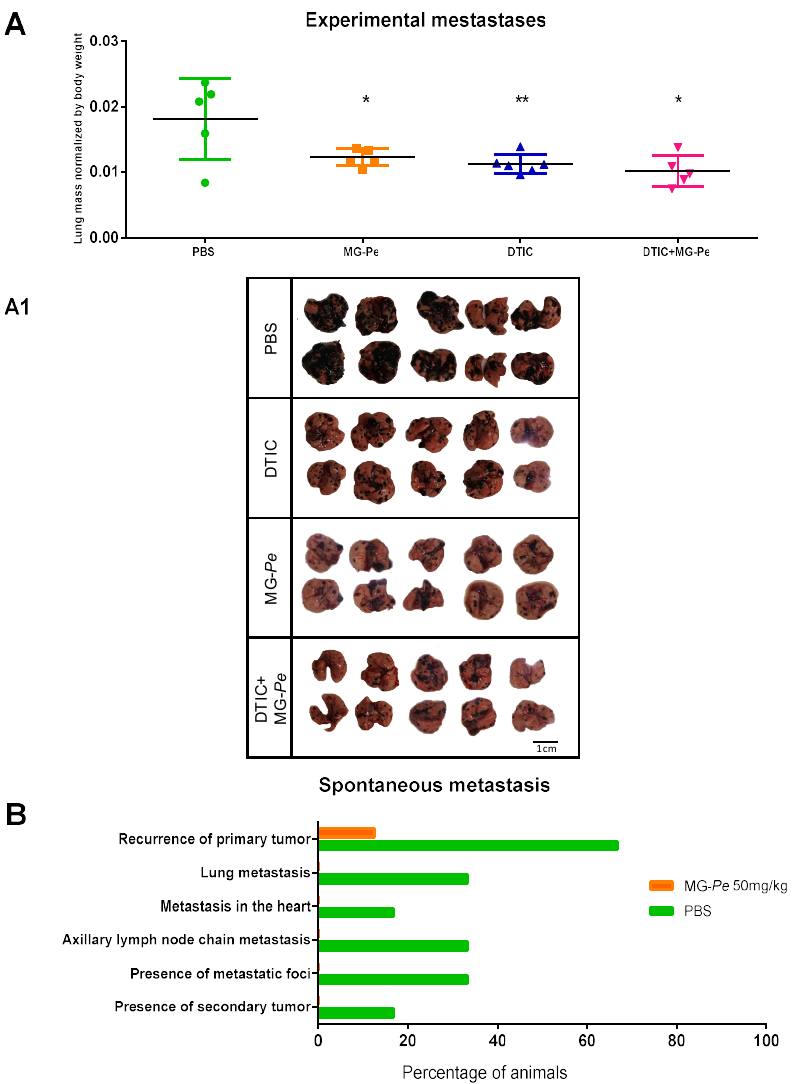
Figure 2 . Analysis of experimental and spontaneous metastases of B16-F10 cells in C57BL/6 mice. ( A ) Experimental metastasis model: cells were intravenously inoculated via lateral caudal vein and treated with: PBS ( n = 5), DTIC (40 mg/kg) ( n = 6), MG-Pe (50 mg/kg) ( n = 6), or DTIC+MG-Pe combination (40 + 50 mg/kg) ( n = 5). The data (mean/SD) were submitted to t -test. * p ≤ 0.05 and ** p ≤ 0.01. ( A1 ) Lung images: dorsal (up) and ventral (down). ( B ) Spontaneous metastasis model: cells were subcutaneously inoculated; animals were treated for 10 days with PBS ( n = 6) or MG-Pe (50 mg/kg) ( n = 8); then tumor removal by surgery (21st day); waited 1 month (without treatment), and finally tumor recurrence was assessed. We evaluated the recurrence of primary tumors in all experimental groups. In the PBS group, 67% of mice (4 of 6 mice) showed tumor development at the surgical removal site (around the 14th day after surgery). By contrast, in the MG- Pe treated group, only 13% of the mice (1 of 8) presented recurrence, on the 16 th day post-surgery. Moreover, for the control group (PBS), the evaluation of all other organs indicated diverse metastatic foci